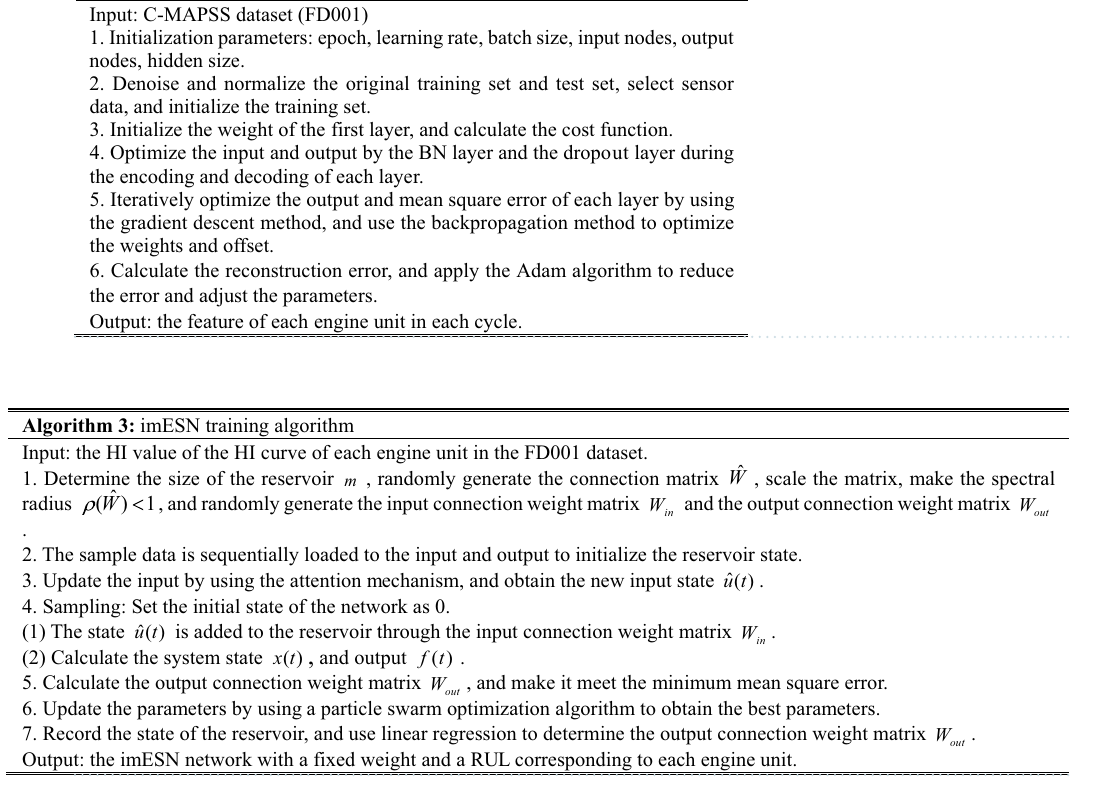
Algorithm 2 : imSSAE training